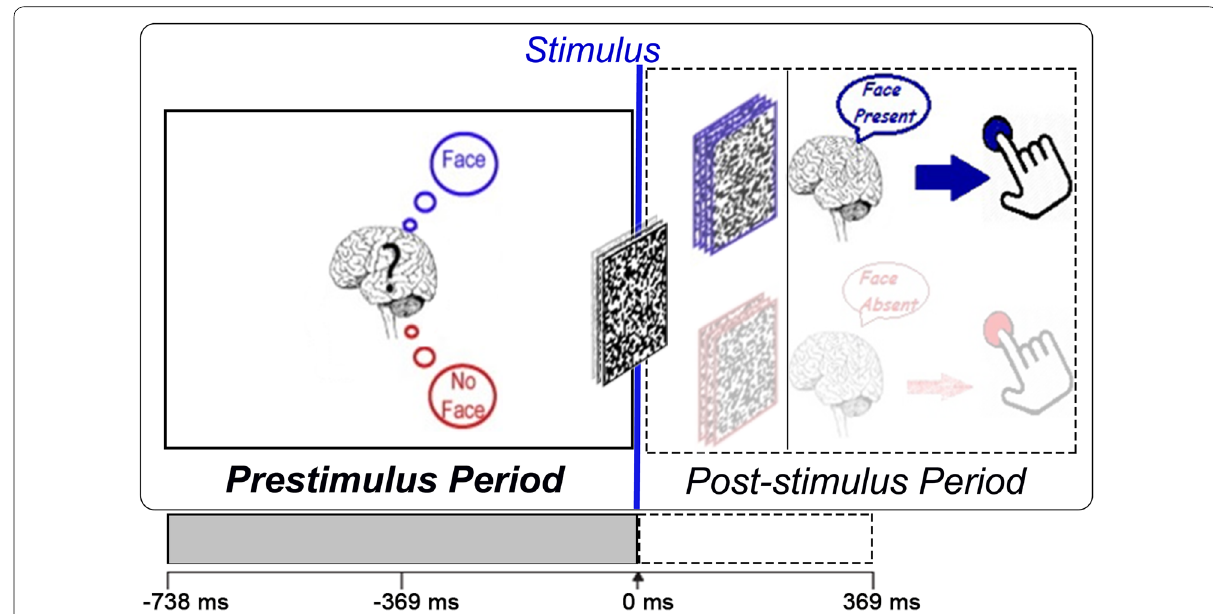
Fig. 2 Experimental paradigm: stimuli were randomly produced visual white noise images. To influence participants’ prior expectation, they were informed that in some of the trials, face would be hidden in the noise stimulus. After stimulus onset, participants were instructed to press one of the two buttons to indicate whether they perceived a face or not. Here, an example of an epoch ( − 738 ms to 369 ms) is presented. Time t represents the stimulus onset. In this study, we focused the 738-ms time period (represented in gray) before the stimulus